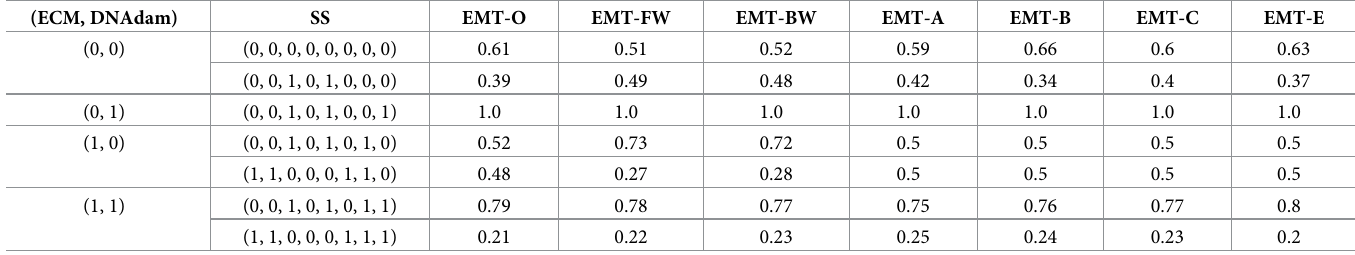
Table 8. Summary of the asynchronous updating results after 90 asynchronous updating simulations for each of the 256 possible initial states. The numbers on the right hand side are frequencies that the simulation reaches the corresponding steady state for the EMT model from [55]. This is an extension to Table 6 with the inclusion of the three selected models from the genetic optimizer EMT-A, EMT-B, and EMT-C, respectively. Furthermore, we include the model found by the expert knowledge guided optimization EMT-E. (ECM,